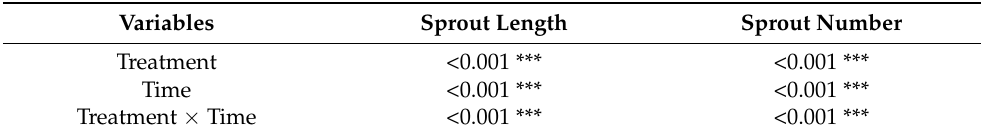
Table 1. ANOVA p -values ( Pr[>F] ) of the linear mixed model for sprout length and number in response to treatment and time and their interactions (*** = statistically significant). Variables Sprout Length Sprout Number